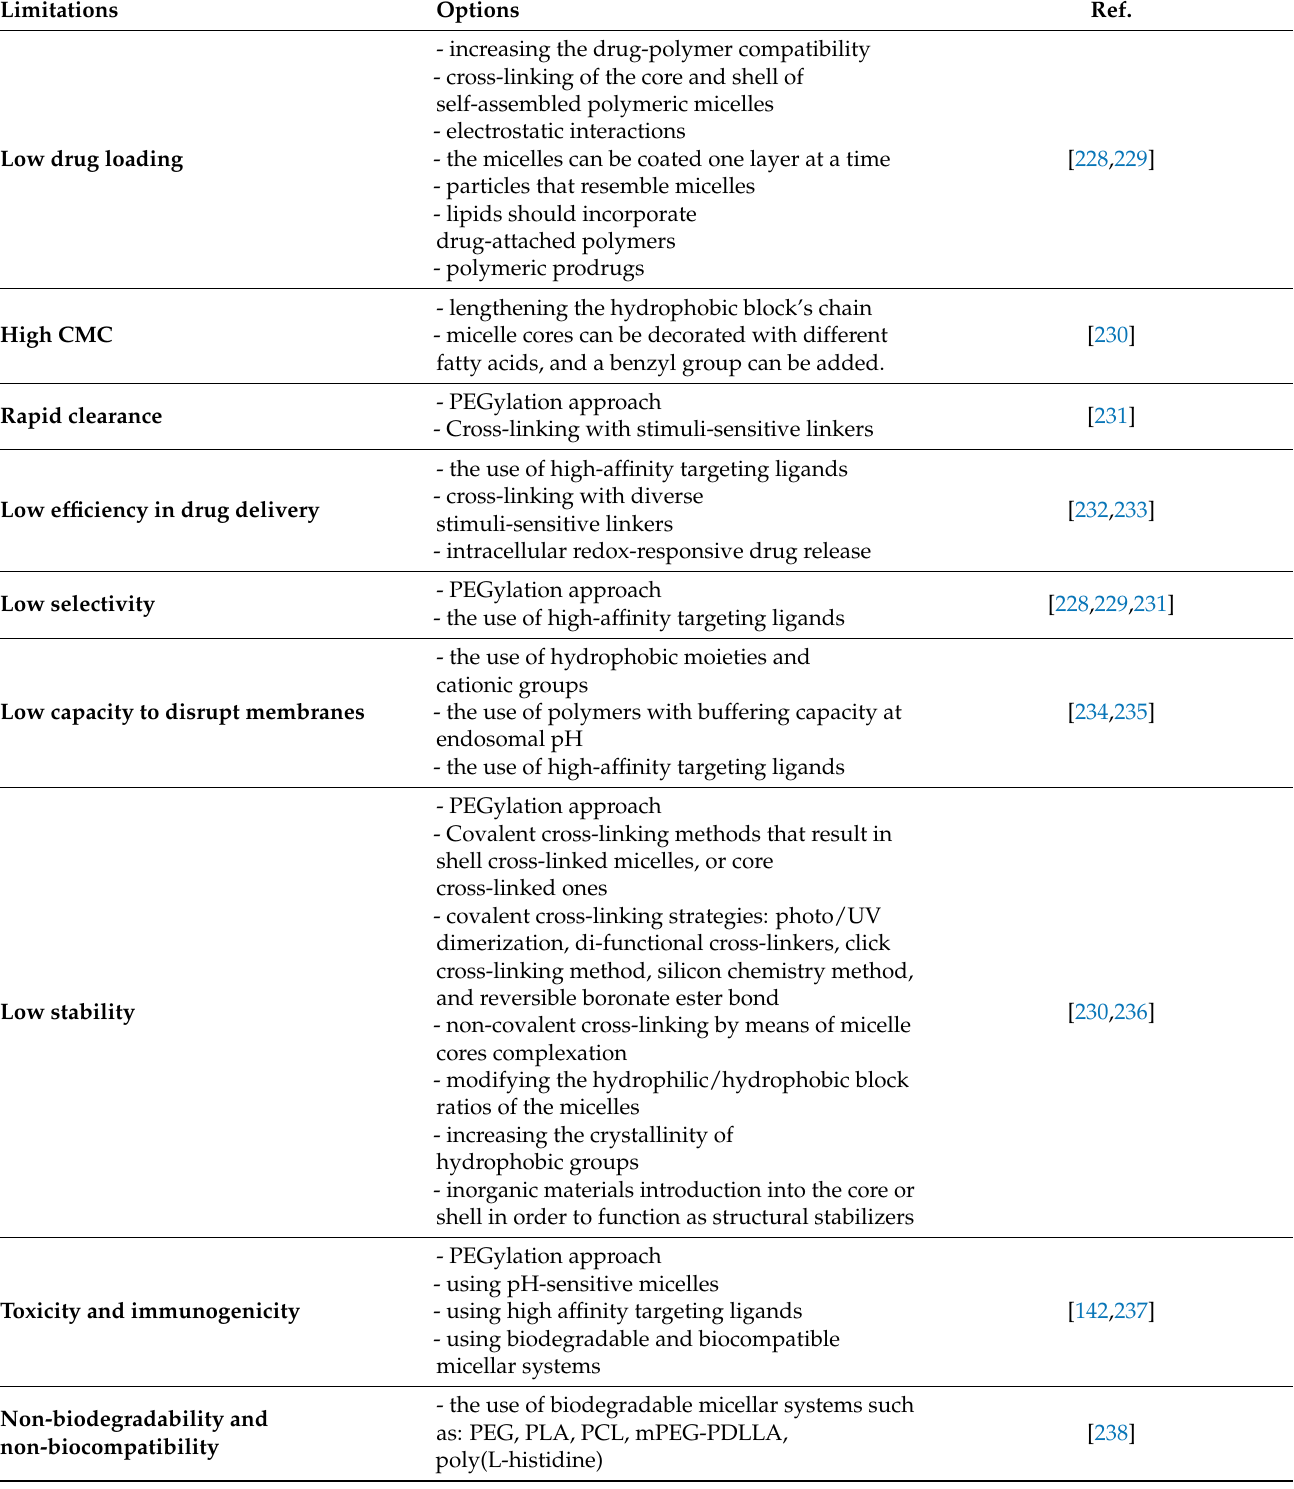
Table 6. Options for overcoming the limits of polymeric micelles